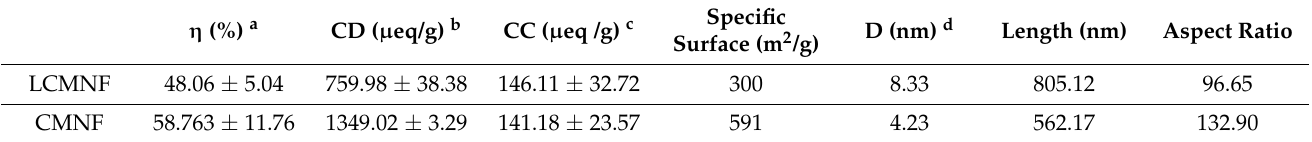
Table 2. Characterization of LCMNFs and CMNFs from bay tree pruning waste